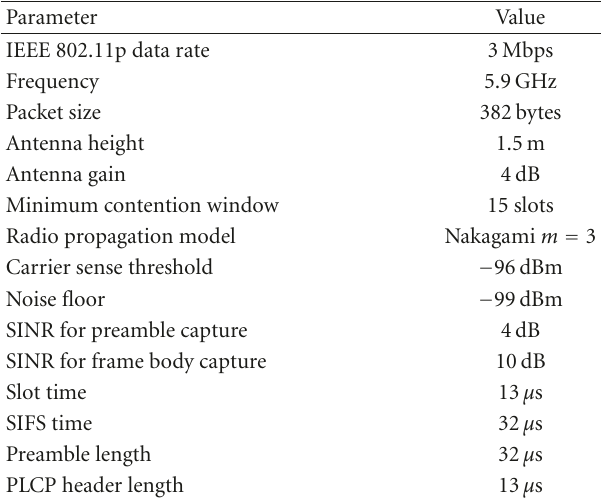
Table 1: Simulation configuration